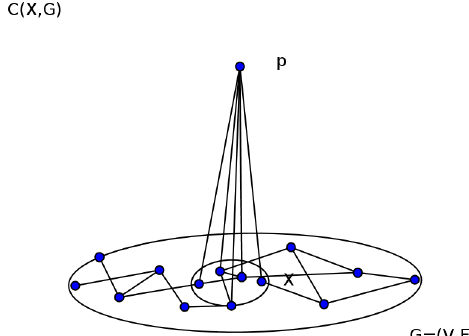
Figure 1: Example of a partial cone C ( X , G )